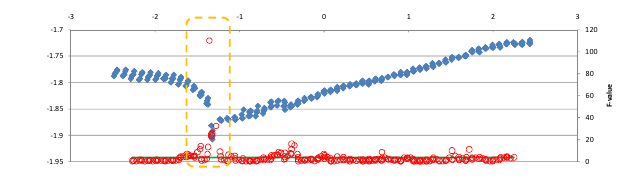
Figure 3. Result(1)